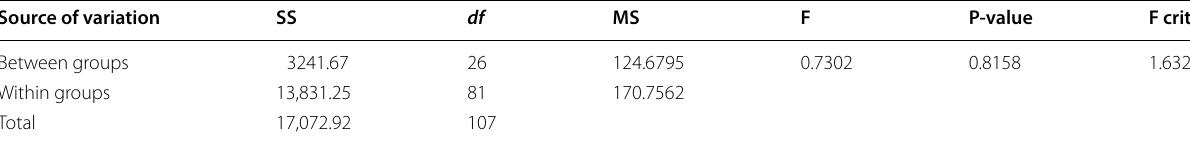
Table 5 Single-factor ANOVA on the percentage agreement of the items in the variable scale “Sustainability of PV project” with α = 0.05 Source of